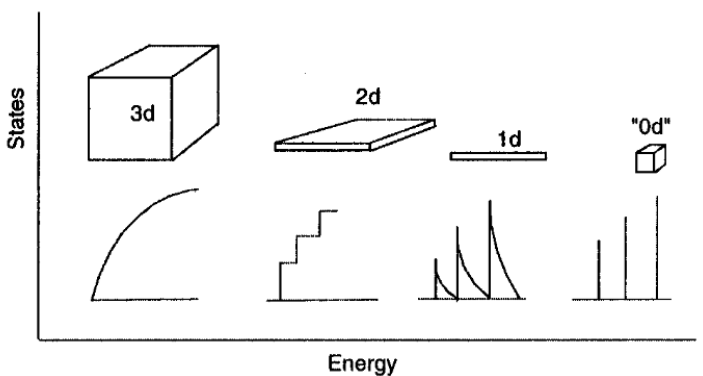
Figure 3. Idealized densities of state for one band semiconductor 3D, 2D, 1D, and 0D structures, indicated in the figure, respectively, as 3d, 2d, 1d, and 0d. In the 3d case (i.e., bulk material), the energy levels are continuous, while in the 0d or molecular limit, the levels are discrete. (Reprinted from [28]; with the permission of the American Chemical Society).